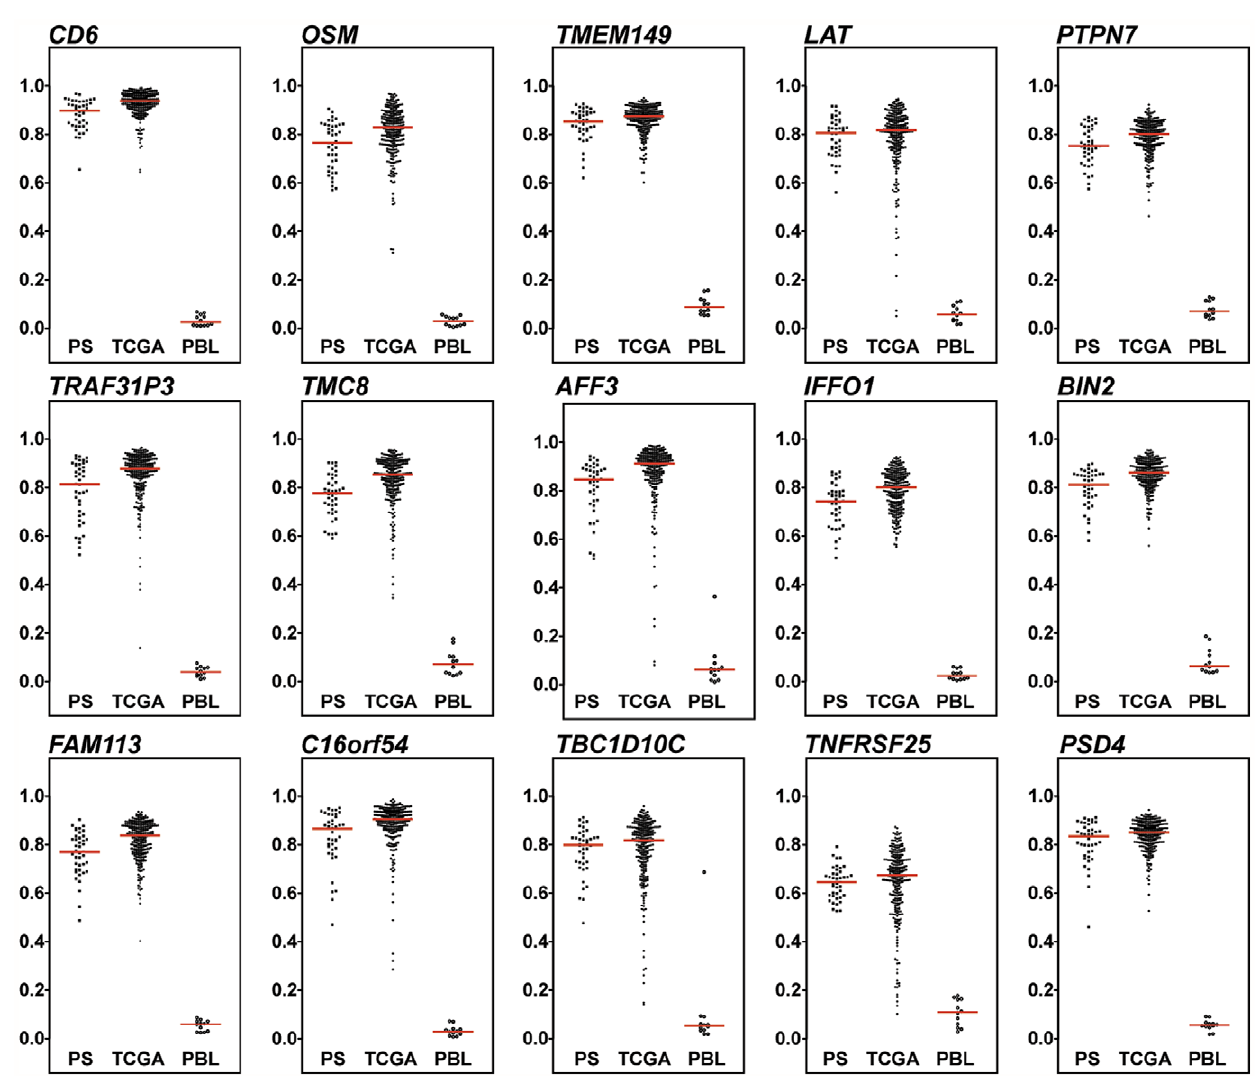
Figure 3. Dot plot display of the top 15-ranked marker distribution in two independent data sets of ovarian cancer samples and ten normal PBL samples. The Infinium-derived b values (Y-axis) for the top 15-ranked markers were compared in the present study (PS) data set (41 ovarian cancers of mixed subtypes), the TCGA data set (284 serous ovarian cancers) and ten normal PBL samples. The horizontal lines represent the median values for each group.